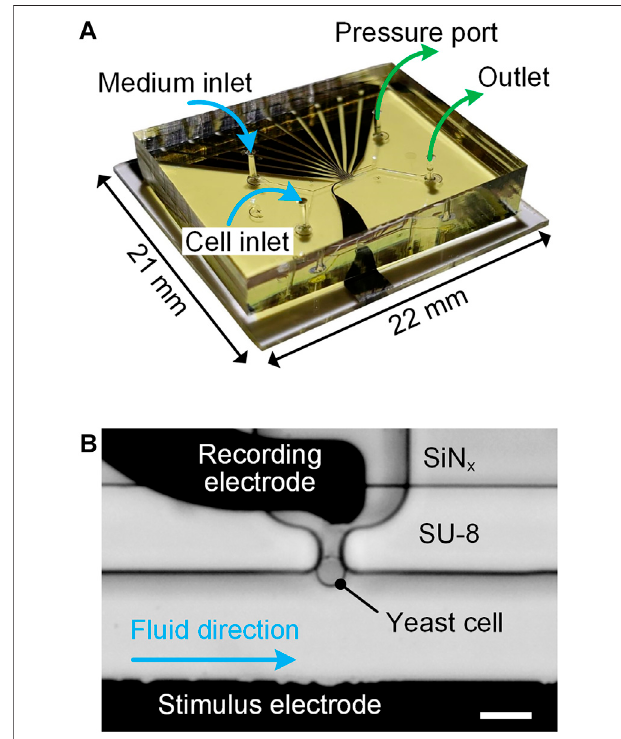
FIGURE 2 | (A) Photograph of an assembled micro fl uidic device indicating fl uidic connections for inlets and outlets. (B) Micrograph of a sensing unit: a bottleneck-like trap immobilized with a single yeast cell. Scale bar is 10 μ